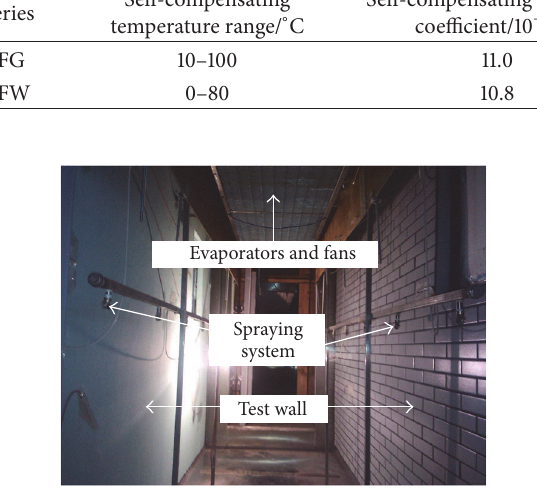
Figure 5: The weathering test